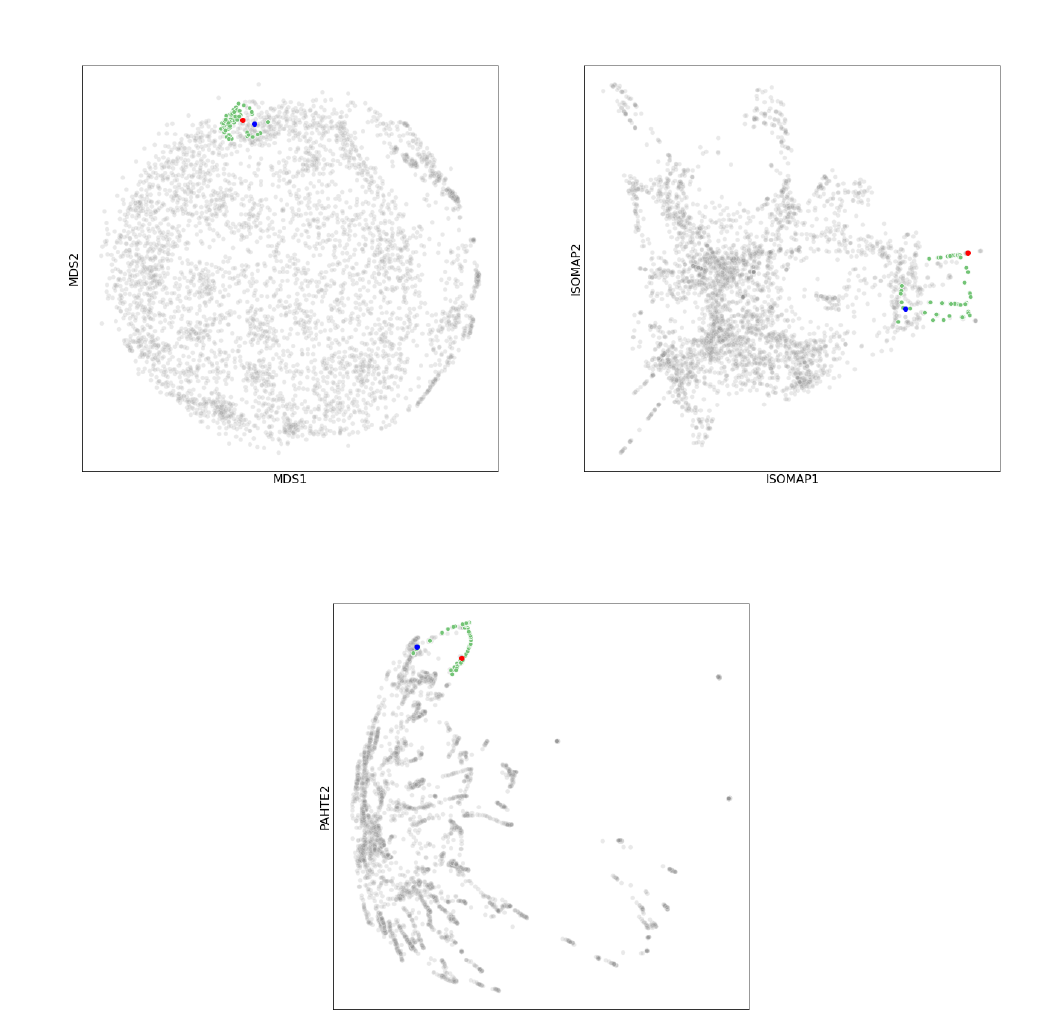
Figure C.1. Multidimensional scaling (MDS), isometric feature mapping (ISOMAP), and potential of heat-diffusion for affinity-based transition embed- ding (PHATE) for the same set of word distributions. A shortest path computed on 10 nearest neighbors graph is highlighted on each embedding with red and blue points indicating the starting and ending points of the path. Note that PHATE identifies the cleanest path connecting the red and blue points, with minimal background noises (grey points) included in